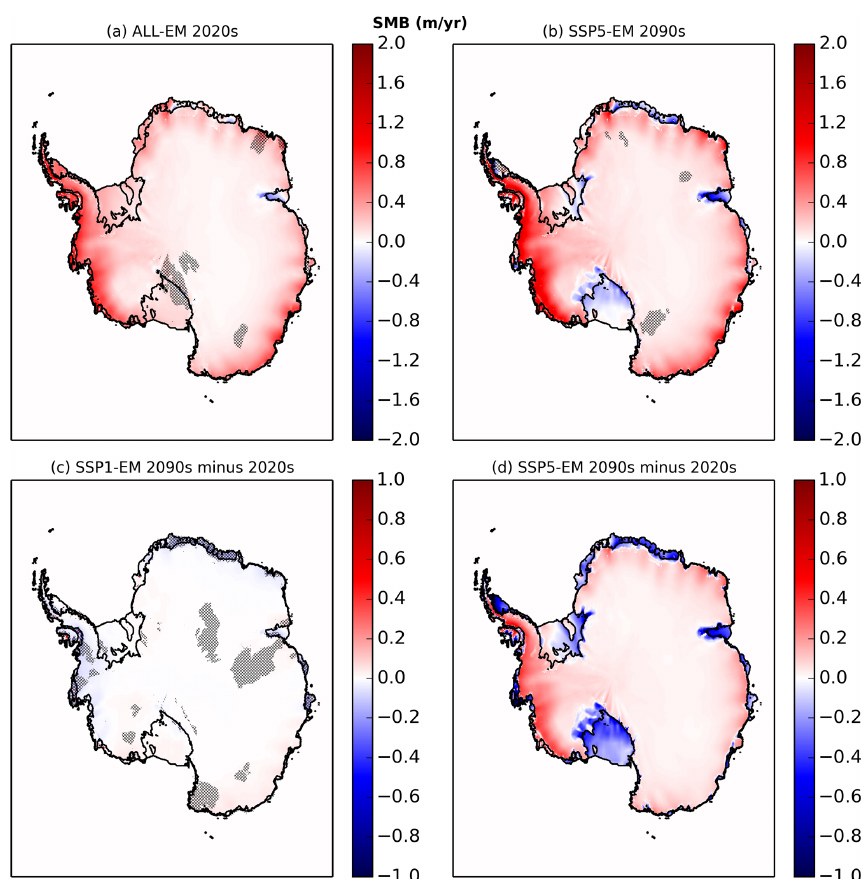
Figure 13. (a) ALL-EM SMB for the period 2020–2030. Locations with a statistically significant difference (95% Student’s t confidence in- terval) between SSP1-EM and SSP5-EM are hatched. (b) SSP5-EM SMB for 2090–2100. Locations with a statistically significant difference (95% confidence interval with one-way ANOVA) among the ensemble members are hatched. (c) Difference in SSP1-EM SMB between the 2090–2100 period and 2020–2030 period. Locations where the difference is statistically significant (95% Student’s t confidence interval) are hatched. (d) Difference in SSP5-EM SMB between the 2090–2100 period and 2020–2030 period; almost everywhere is statistically significant. Black and grey lines indicate the ice sheet grounding lines and ice shelf fronts, respectively.